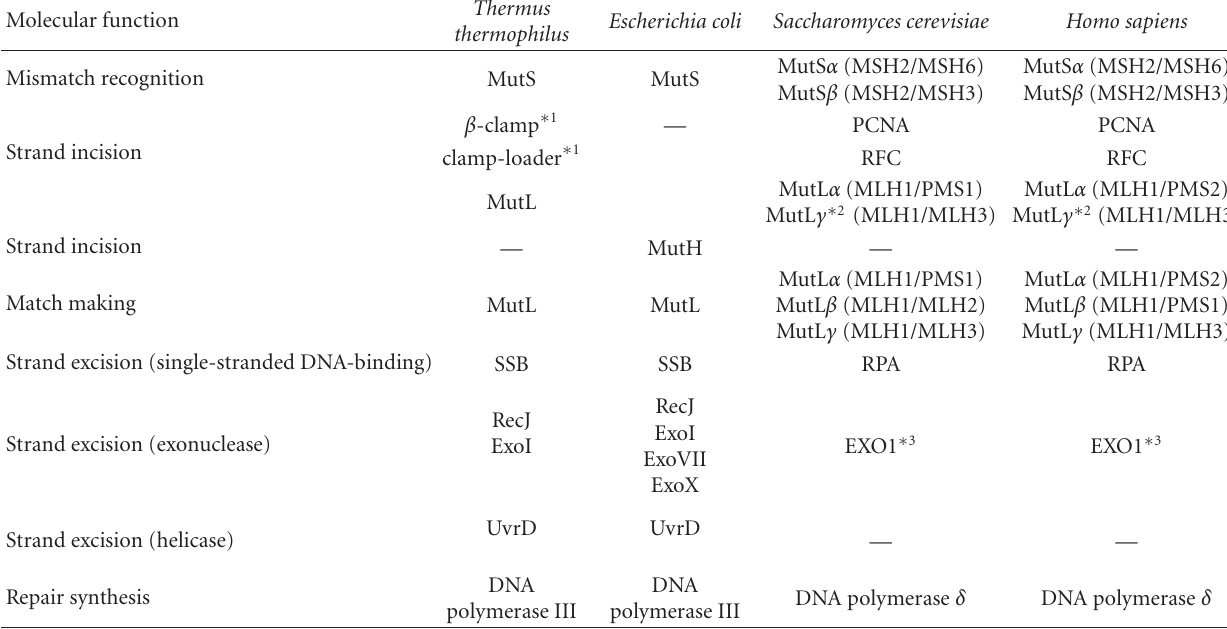
Table 1: Distribution of MMR proteins.